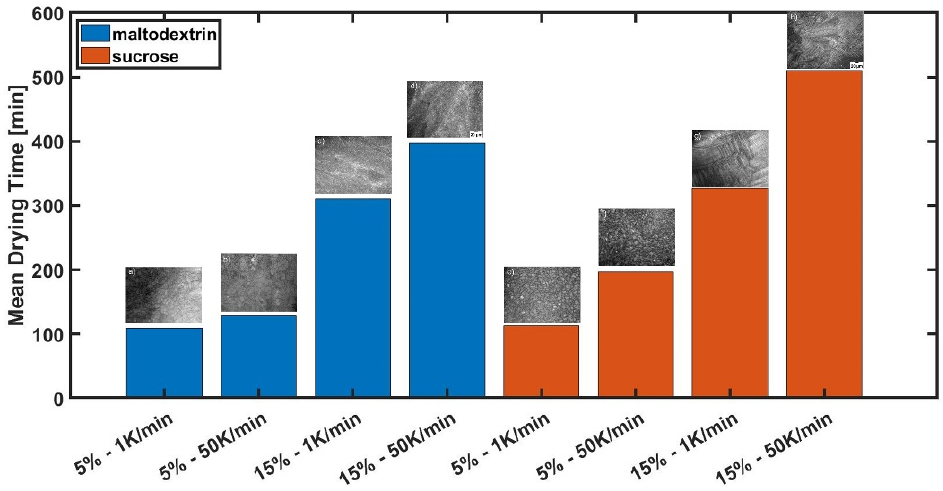
Figure 7. Effect of different cooling rates of a sucrose solution (c = 0.05 w/w) on ( a ) pore size distribution and ( b ) aspect ratio.